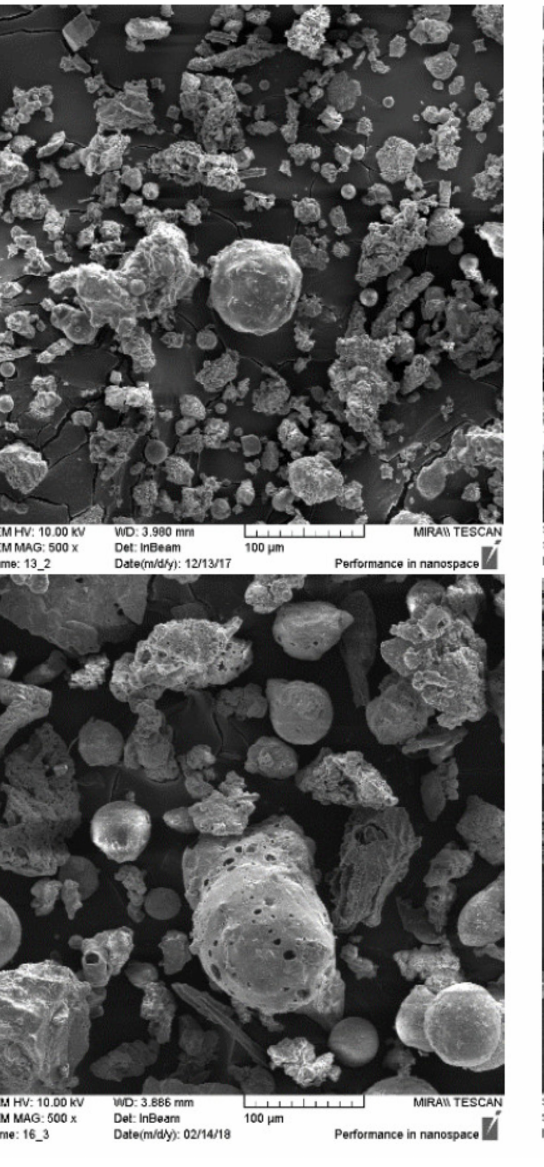
Figure 6. Pores in the reference concrete and reference sample with different proportions of WWA and SF (used from an open source journal of MDPI